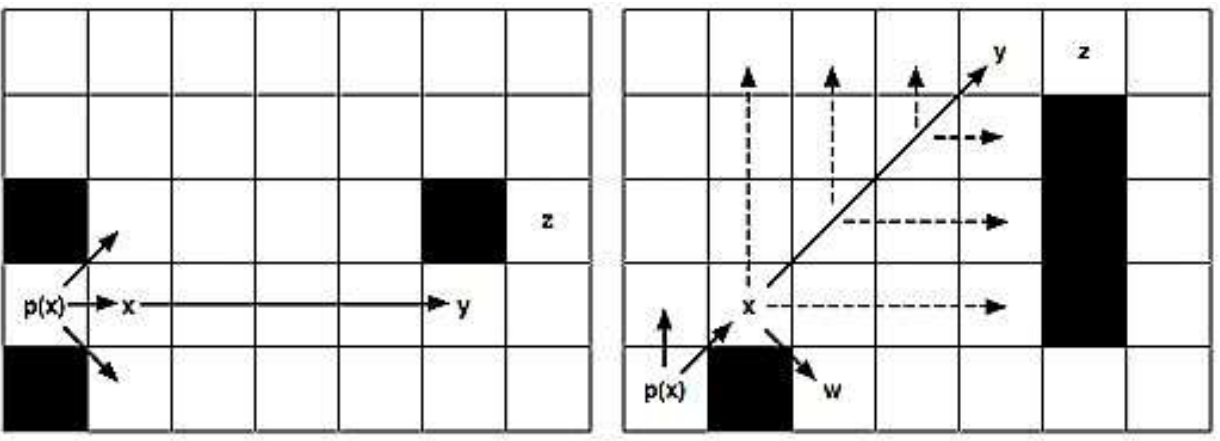
Figure 9. Left : from a jump point x (with parent p(x)), the Algorithm recursively goes straight until y and sets it as a successor jump point of x. Right : from a Jump Point x (with parent p(x)), the Algorithm recursively goes diagonally until y and set it as an x Jump Point Successor.